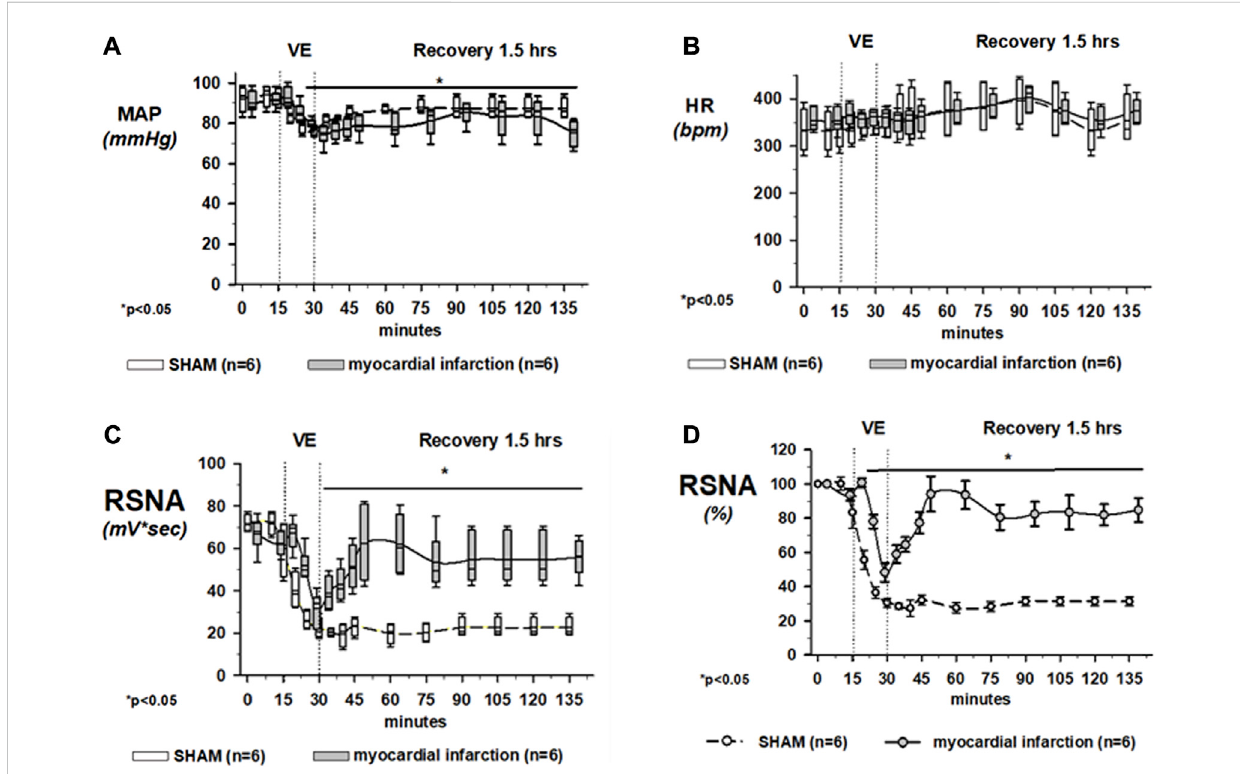
FIGURE 7 Effects of volume loading on the mean arterial blood pressure (MAP) and the heart rate (HR). Upper panel (A) : volume expansion lowered the mean arterialbloodpressureinallgroupsslightlybutsigni fi cantly.Upperpanel (B) :heartratewasnotspeci fi callyin fl uencedbyvolumeloading.Volumeloading unmasked renal sympathetic dysregulation in rats after myocardial infarction without overt congestive heart failure (cardiopulmonary barore fl ex). Lower panel (C) : effects of 30-min volume expansion (VE) with saline (10% body weight) on renal sympathetic nerve activity (RSNA) in rats with coronary arteryligature(myocardialinfarction;dottedline; n =9)orcontrolanimals(control;solidline; n =6).Alldataarepresentedasboxandwhiskers.* p < 0.05. Asterisks represent signi fi cant differences from RSNA baselines. Lower panel (D) : Raw data of the integrated renal sympathetic nerve recordings are normalized, and the changes are presented in present change from baseline. Using this way of presentation, in rats with myocardial infarction, renal sympatheticnerveactivitywasnolongersuppressedtothesamedegreeasincontrolsattheendofthe30-minvolumeexpansion.Dataarepresentedas mean ± SEM since data expressed in percent are normally distributed. * p < 0.05. Asterisks represent signi fi cant differences from RSNA baselines. In any case, rats with coronary artery ligature exhibited a distinctly different response pattern of RSNA to volume expansion as compared to that of normal controls. Kruskal – Wallis one-way ANOVA on ranks was used with Dunn ’ s post - hoc method. For panel (D) , statistical analysis was done using one-way ANOVA with a Student – Newman – Keuls post hoc . Rats were taken from the groups of rats with myocardial infarction or SHAM controls that were exposed to volume